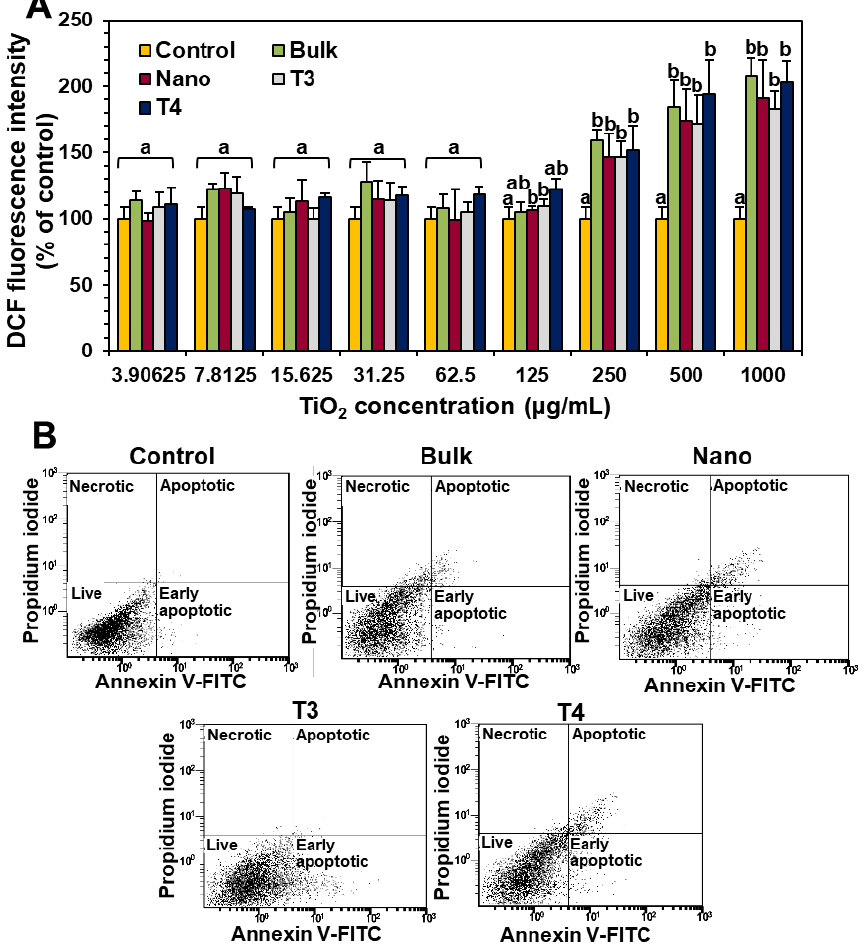
Figure 8. The effect of TiO 2 particles on ( A ) intracellular reactive oxygen species (ROS) generation and ( B ) apoptosis induction in Caco-2 cells after 24 h. Different lowercase letters (a, b) indicate significant differences among control (cells without particles) and different TiO 2 particles (food-grade T3, T4, general-grade bulk and nano) ( p < 0.05).